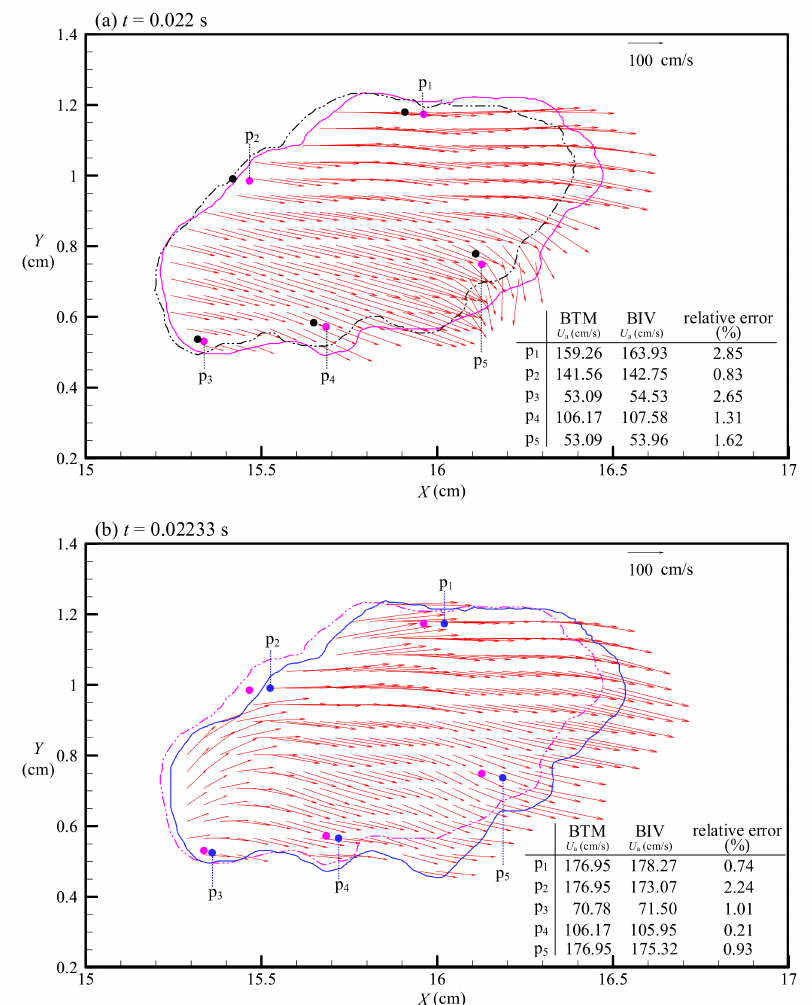
Figure 16. Two magnified views for the instantaneous velocity field of air bubbles A measured by BTM and BIV at ( a ) t = 0.02200 s; ( b ) t = 0.02233